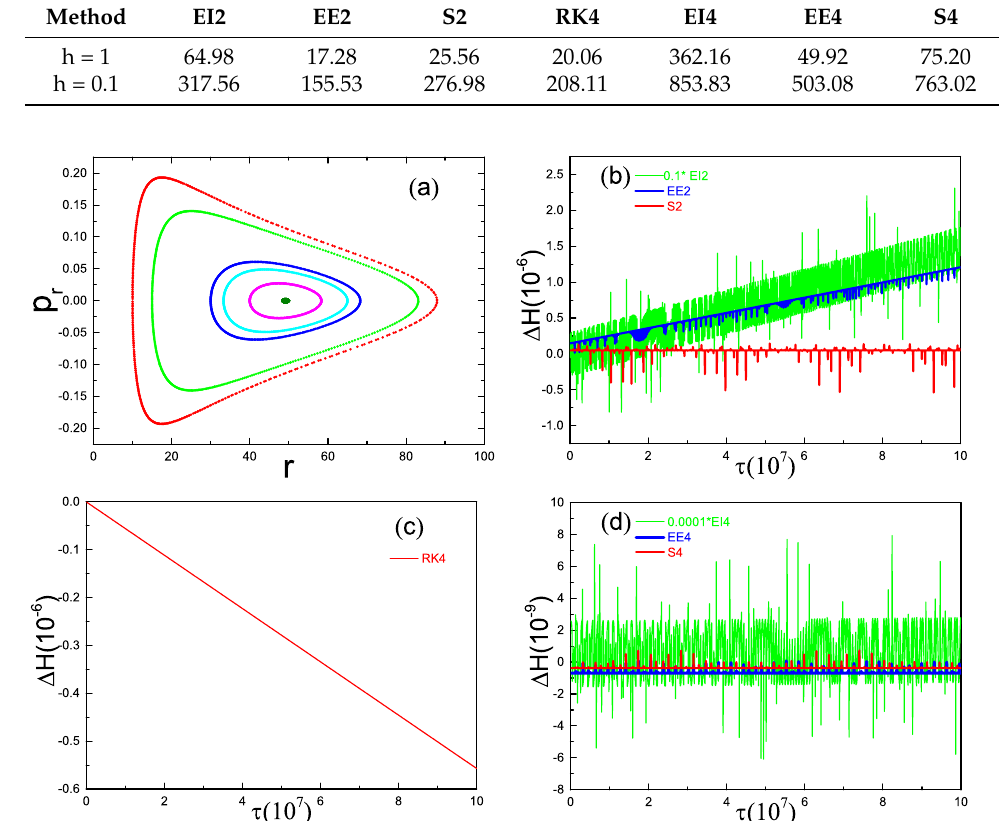
Figure 1. Numerical test performance. ( a ) Poincaré sections on the plane θ = π /2. The parameters are E = 0.9900, L = 4.6, α = 10 − 12 , β = 0, b = 0. Initial conditions of orbit 1 colored red are r = 10, p r = 0, θ = π /2, and p θ is determined by Equations (11) and (12). The other orbits are r = 15,30,40,50 and r = 65. ( b – d ) Hamiltonian errors ∆ H = H − ( − 1/2 ) of orbit 1 for different algorithms. The proper time step is h =